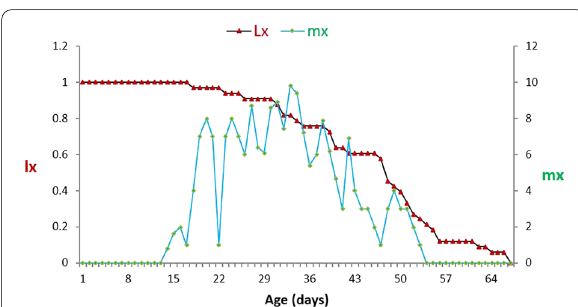
Fig. 2 Age specific survival ( l x ) and fertility ( m x ) of adult female, H. dimidiata fed on R. padi aphid at 20